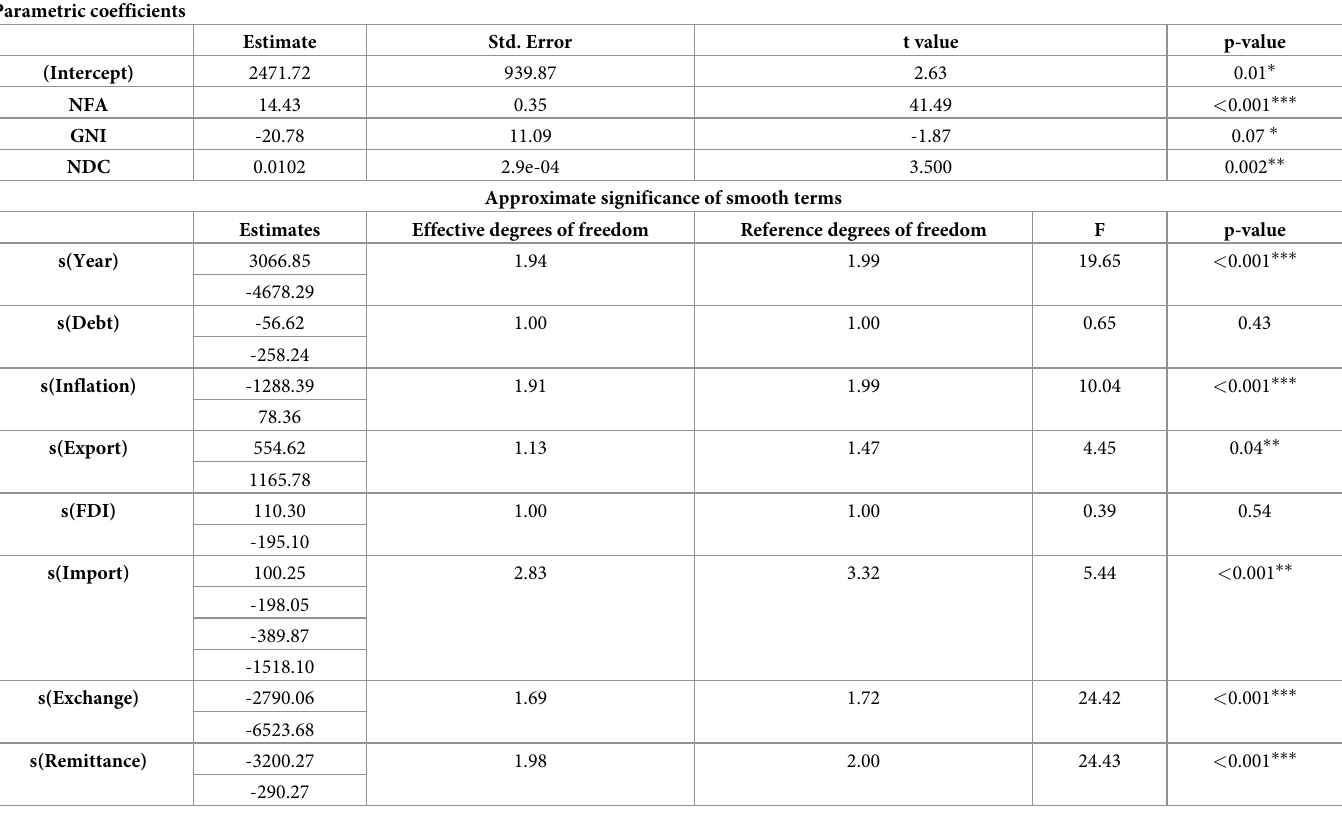
Table 3. Estimates of GAM